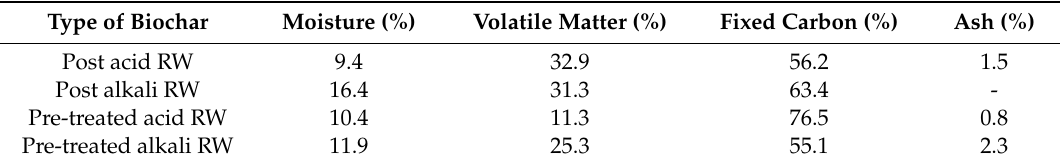
Table 5. Proximate analysis of chemical treated carbon